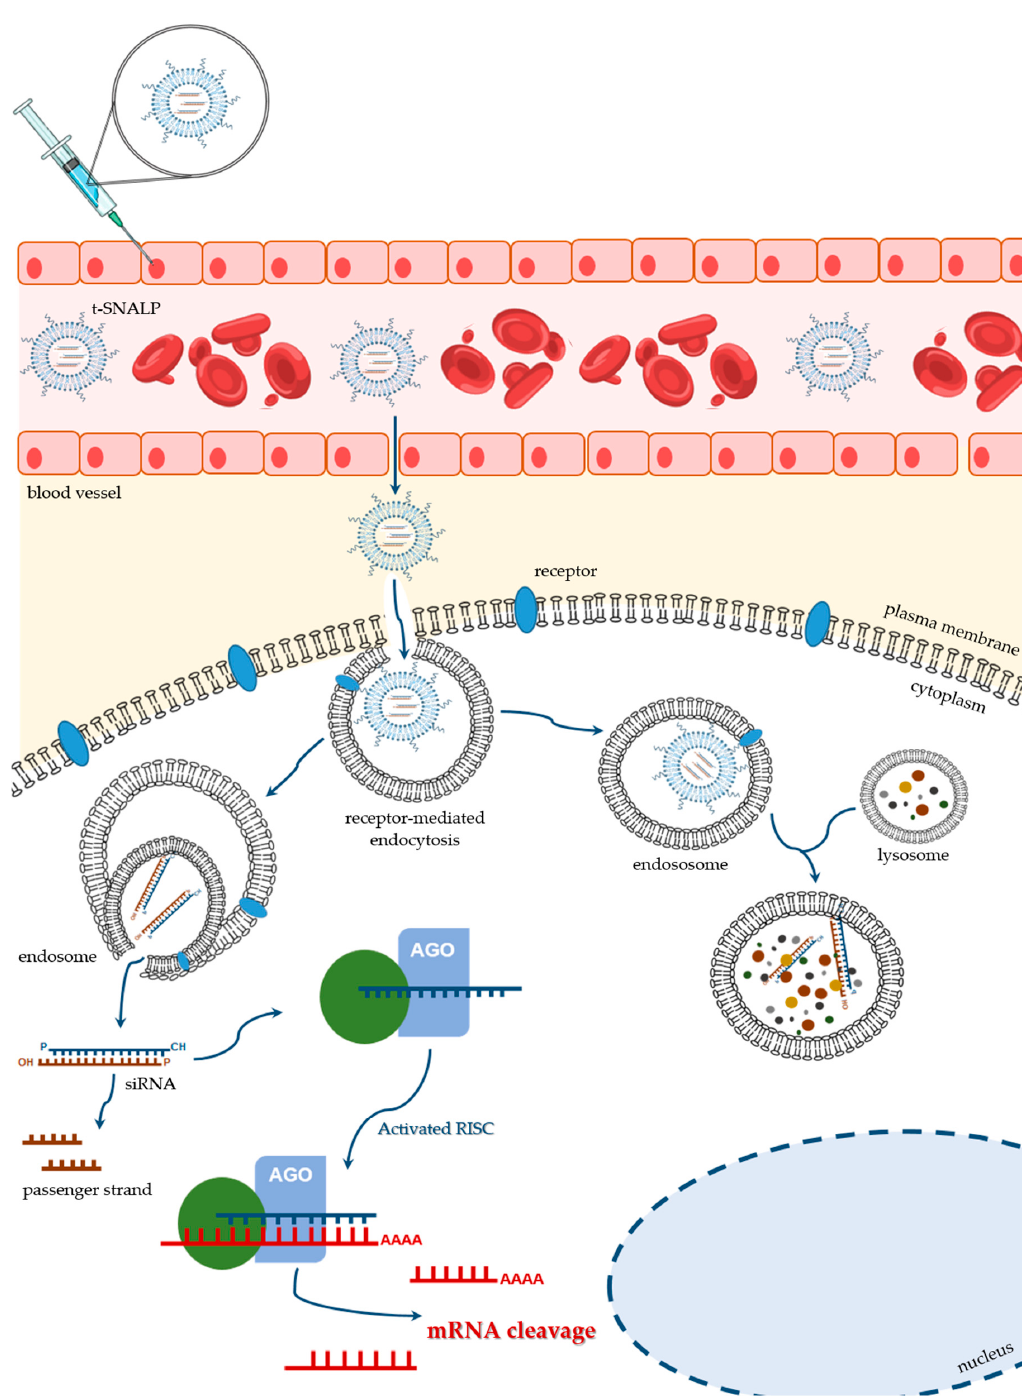
Figure 4. Schematic representation of the ligand-mediated SNALP targeting for delivery of therapeutic siRNAs. After being injected into the bloodstream, t-SNALPs must cross the endothelial barrier and diffuse through the extracellular matrix. When reaching their target cells, the engineered ligands, which are covalently attached to the SNALP surface, interact specifically with their receptors on the plasma membrane. That interaction will result in the t-SNALP internalization through receptor-mediated endocytosis, for example. Once inside the cell, siRNAs must escape the endocytic pathway (right side of the picture) and avoid lysosomal destruction. Instead, siRNAs need to be unpacked and released into the cytoplasm, where they can be incorporated into the RNAi machinery (left side of the picture) and actively promote the silencing of their target